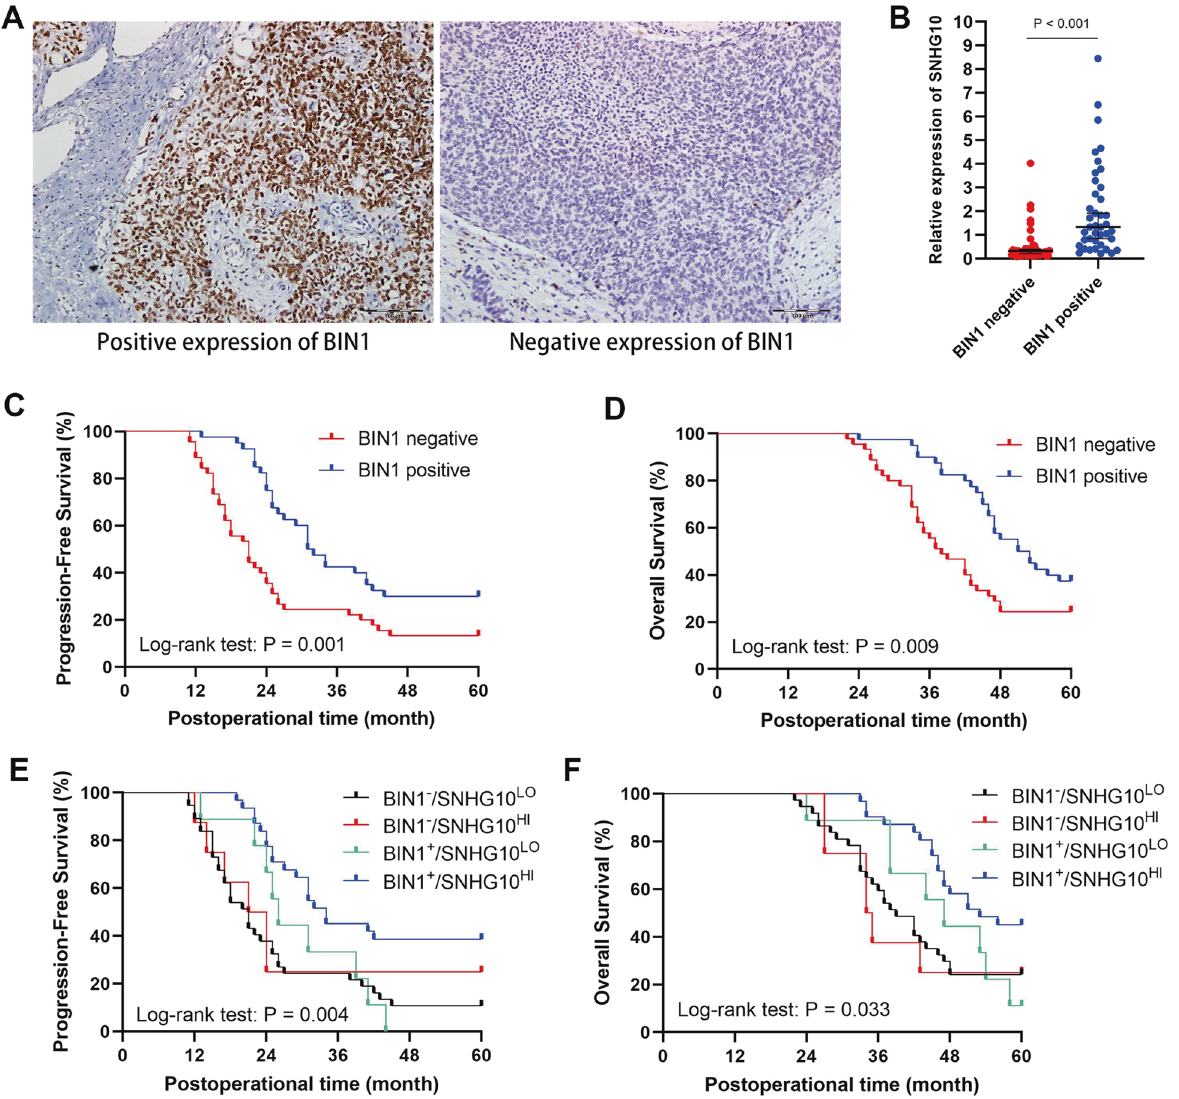
with the OS of EOC patients. The experiments were conducted in